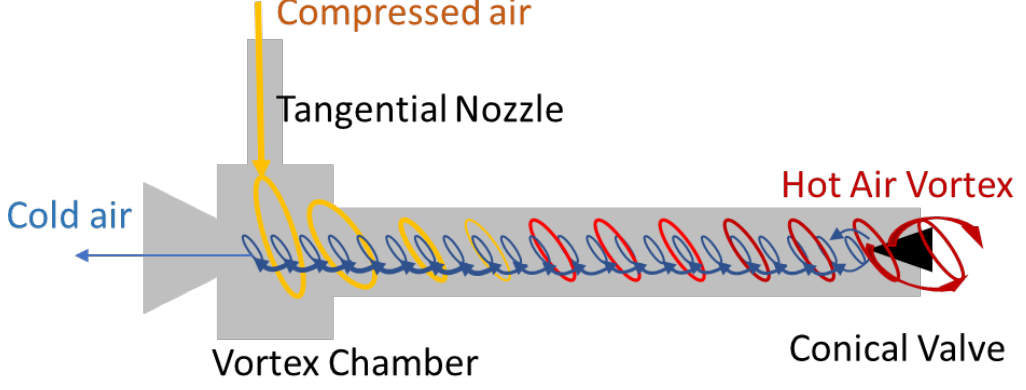
Figure 2. Schematic of vortex tube method of operation. Table 1. Experimental